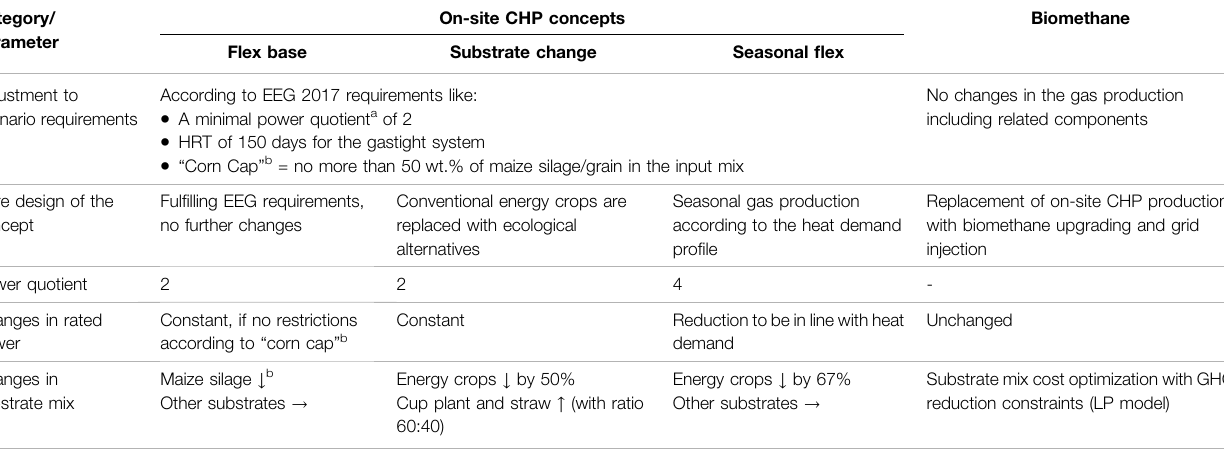
TABLE 1 | Core design, adjustments, and impacts on power output and substrate mix of the four selected follow-up concepts. Category/ On-site CHP concepts Biomethane parameter Flex base Substrate change Seasonal fl